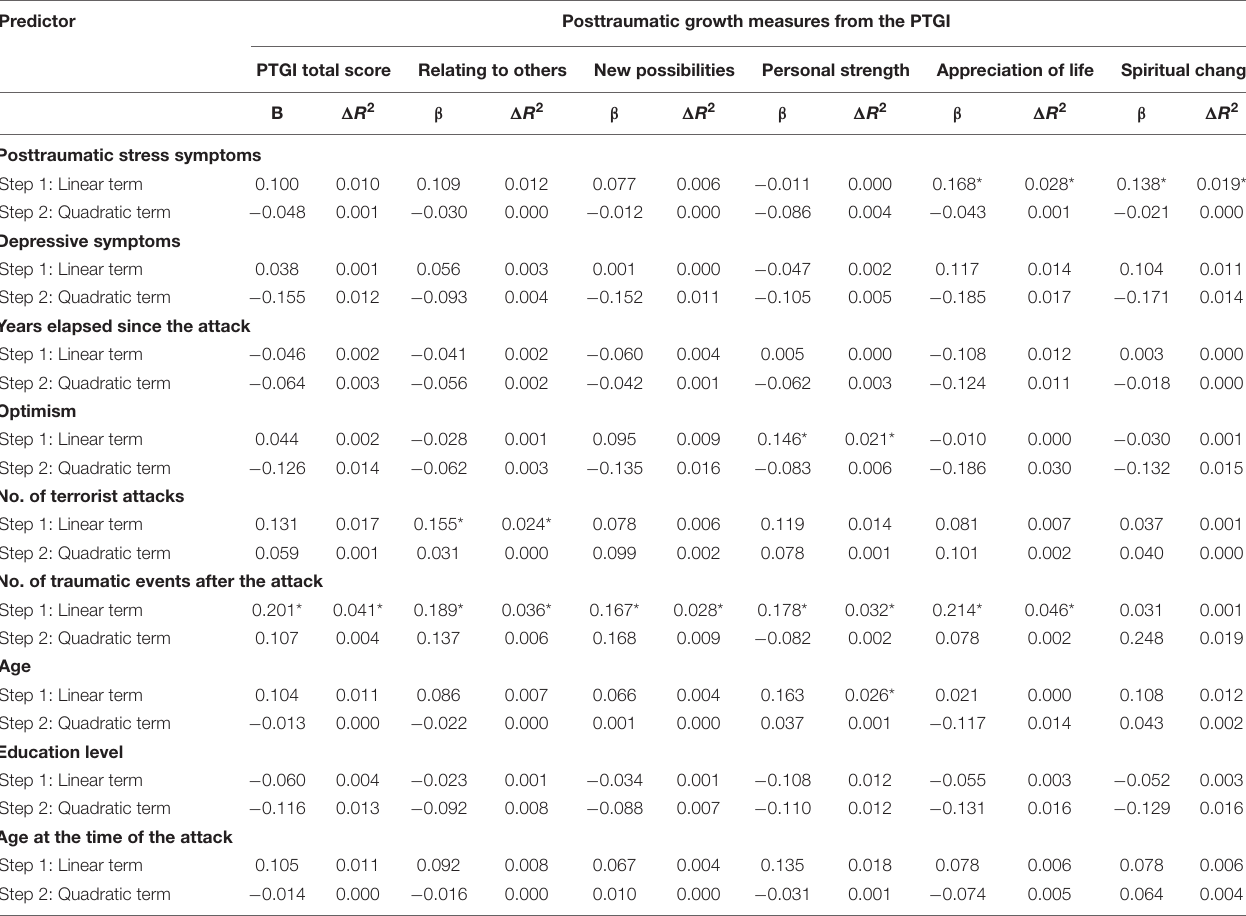
TABLE 5 | Linear and curvilinear relationships between the continuous predictors and the posttraumatic growth measures from the PTGI: Multiple regression analyses. Predictor Posttraumatic growth measures from the PTGI PTGI total score Relating to others New possibilities Personal strength Appreciation of life Spiritual